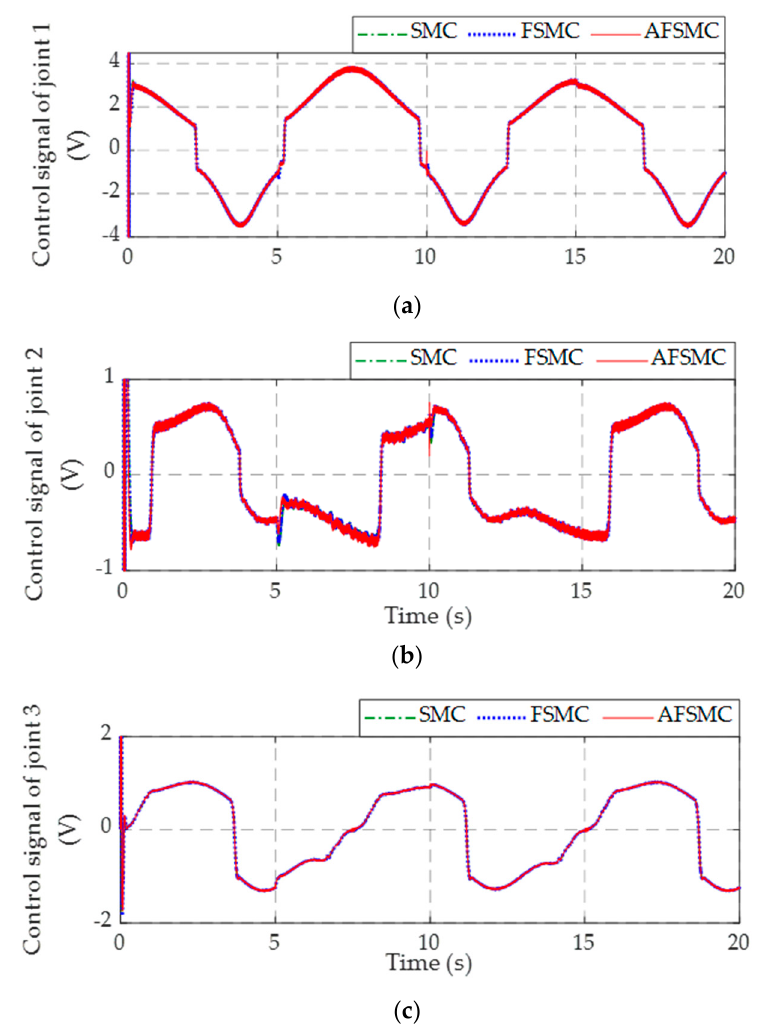
Figure 20. The control signal acting on the: ( a ) first joint, ( b ) second joint, and ( c ) third joint.